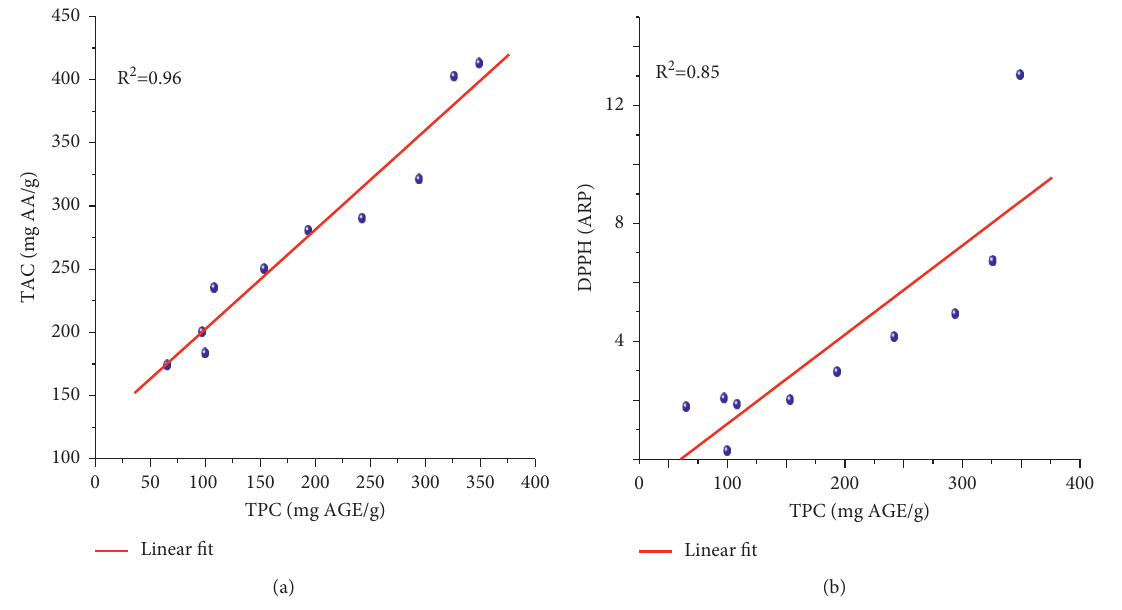
Figure 3: Linear dependency between the antioxidant activity TPC and DPPH